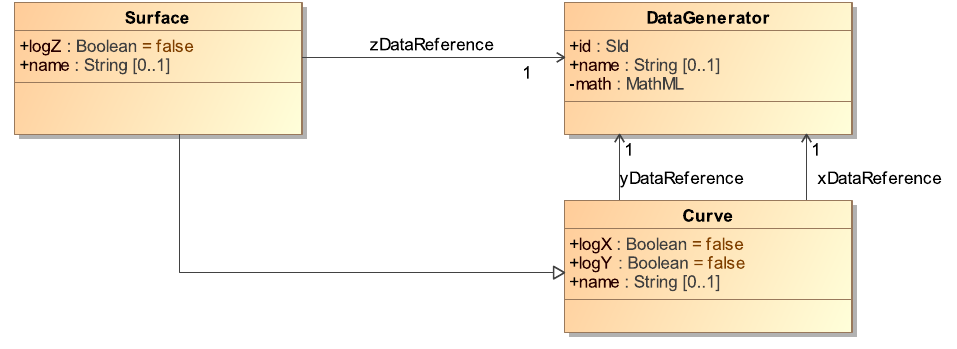
Figure 2.44: The SED-ML Surface class